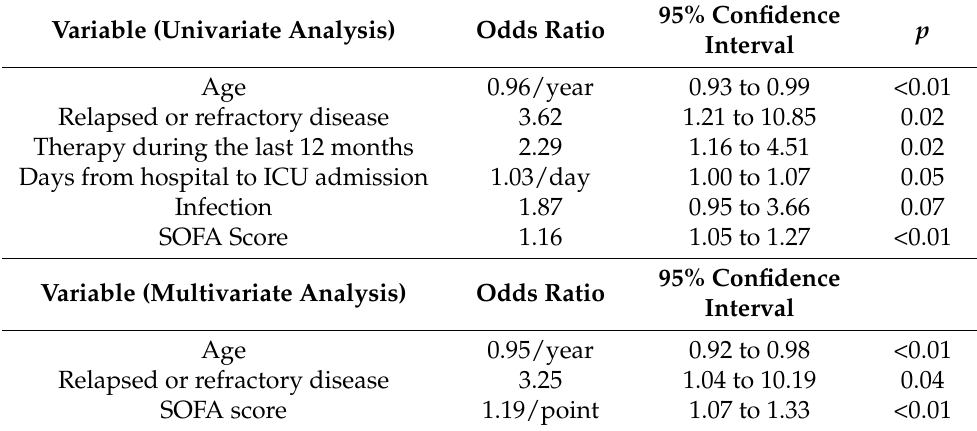
Table 2. Logistic regression analysis regarding 25(OH) D deficiency (<20